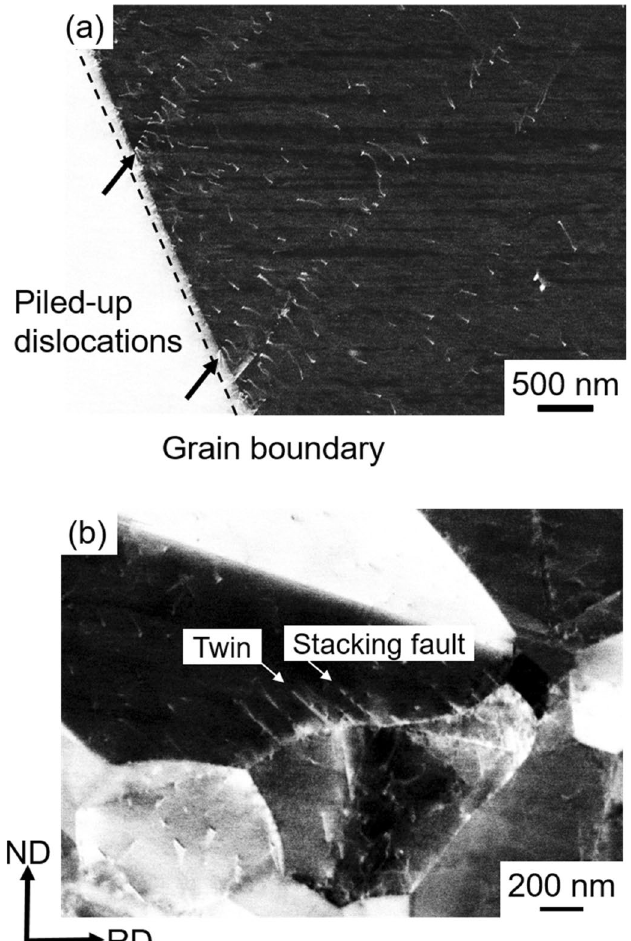
Figure 4. ECC images of the specimens with the mean grain sizes of ( a ) 15.4 μm and ( b ) 0.79 μm deformed to the engineering strains ( e ) of 0.007 and 0.016, respectively. The broken line in ( a ) indicates a grain boundary. The grain on the left side of the grain boundary showed a uniform white contrast, because orientation of the grain did not satisfy the Bragg condition under the present ECCI observation condition. Piled-up dislocations, stacking faults and deformation twins were indicated by arrows in the figures. ( b ) was shown in 48